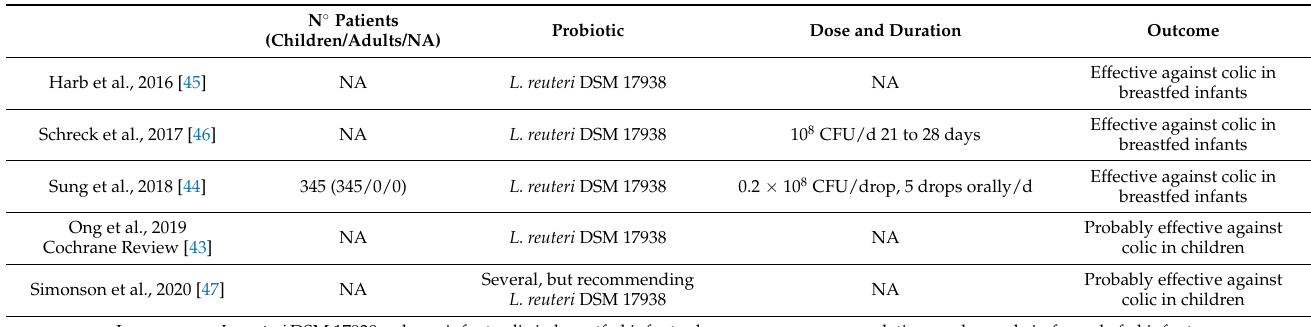
Table 6. Meta-analyses and systematic reviews on probiotics in infantile colic. N ◦ Patients (Children/Adults/NA) Probiotic Dose and